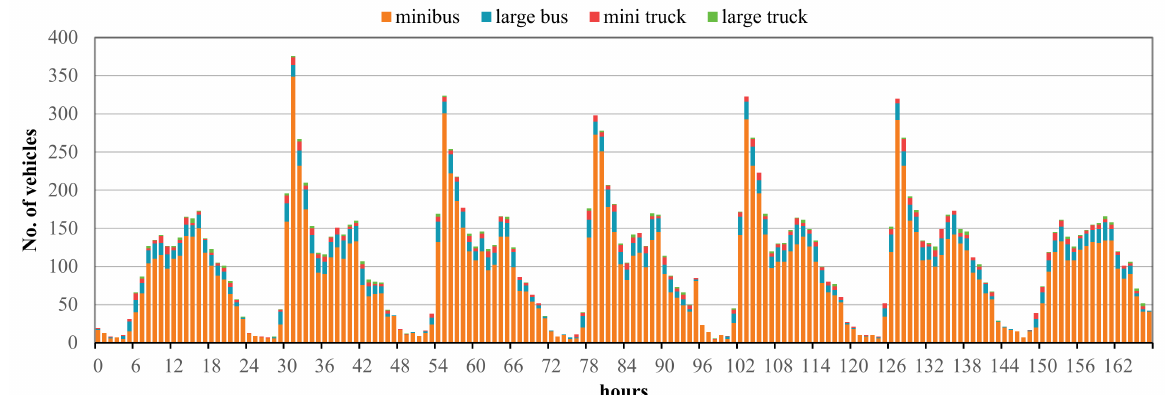
Figure 1. Hourly traffic flow of a typical urban